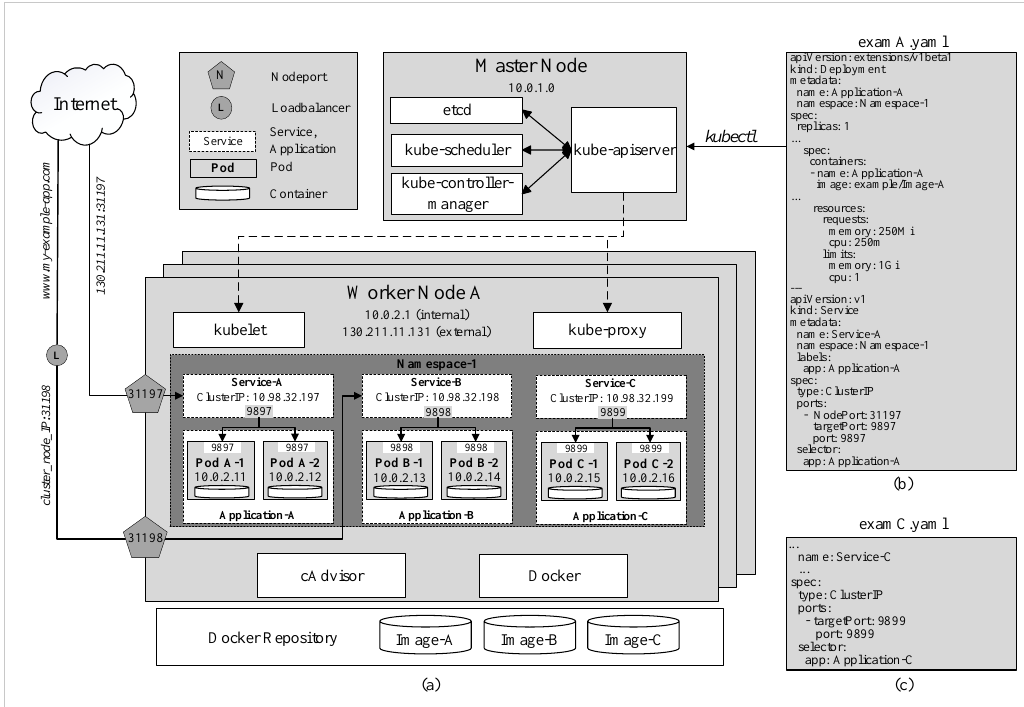
Figure 1. ( a ) The architecture of Kubernetes. ( b , c ) Examples of YAML code for application deployment in